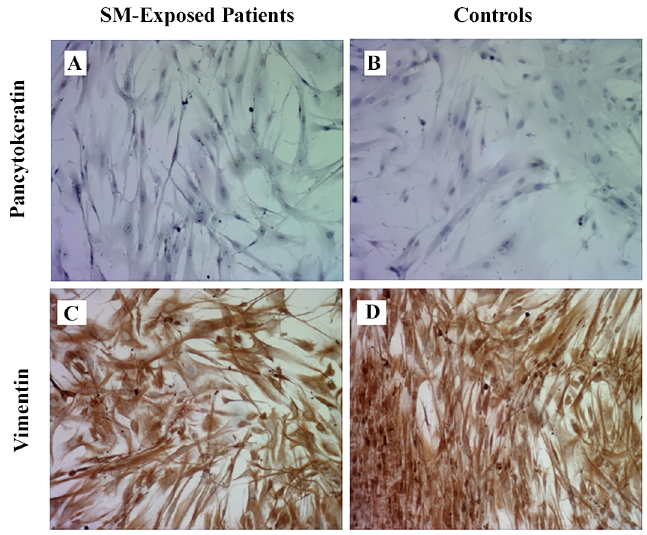
Fig 1. Immunocytochemical characterization of fibroblasts. The cells from both SM-exposed patients and controls were negative for pancytokeratin staining (A and B; 10×) and positive for vimentin (C and D;